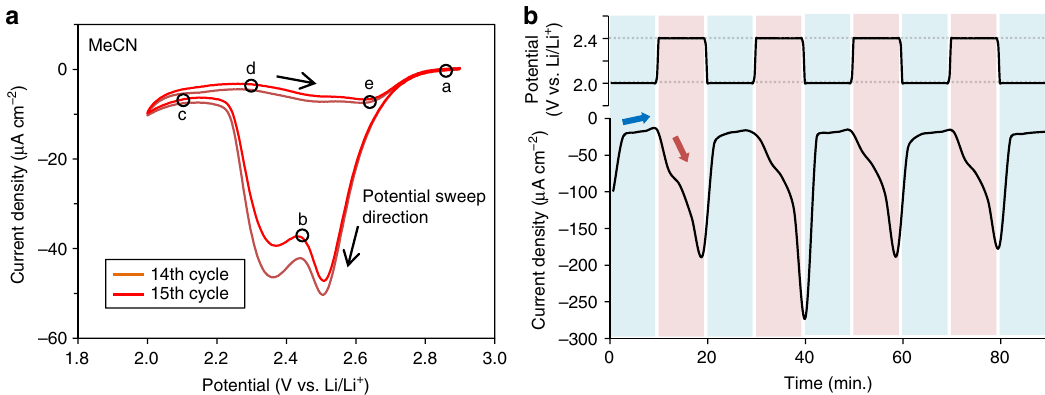
Fig. 4 Negative differential resistance (NDR) of ORR potential region. a The CVs of the 14th and 15th cycles for MeCN system using 2-electrode set up with CP for working electrode. The potential scan rate was 0.5 mV s − 1 . The current increase between point d and e in the positive sweep shows the NDR. b The time course of the ORR current for the MeCN system at the constant potential of 2.0 and 2.4 V obtained after 10 cycles of CV measurement. The potential was switched at